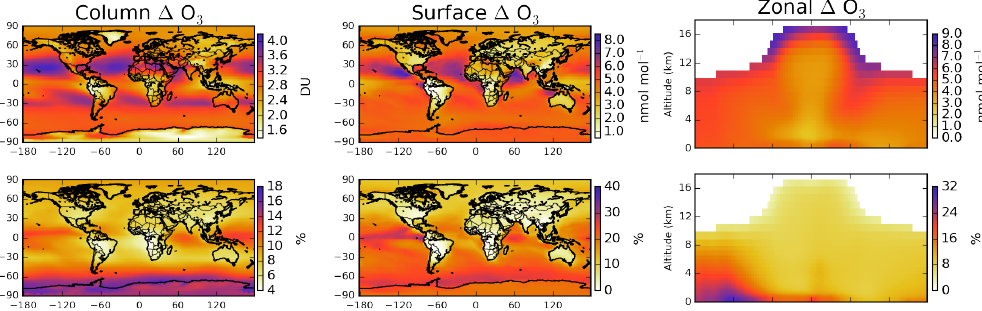
Figure 10. Decreases in annual mean tropospheric column, surface, and zonal O 3 with inclusion of iodine (“Br + I”–“BROMINE”) chemistry are shown on left, middle, and right panels respectively. Upper panels show changes in Dobson units or nmolmol − 1 and lower panels show changes in percentage